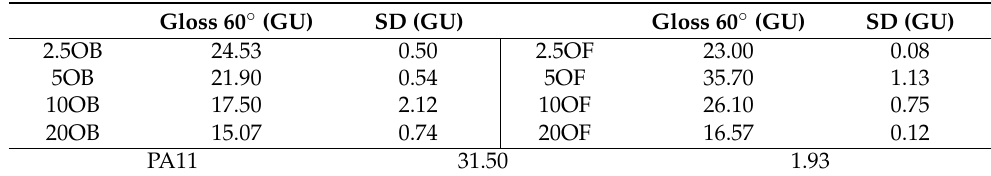
Table 6. Gloss of biocomposite surfaces.